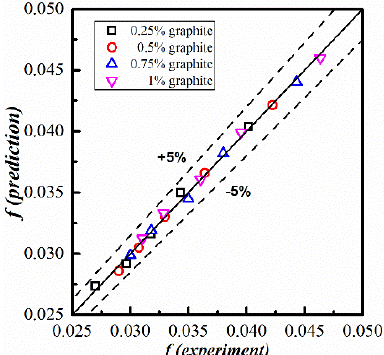
Figure 6. Comparison of f between the experiments and the predictions from the regression equation.